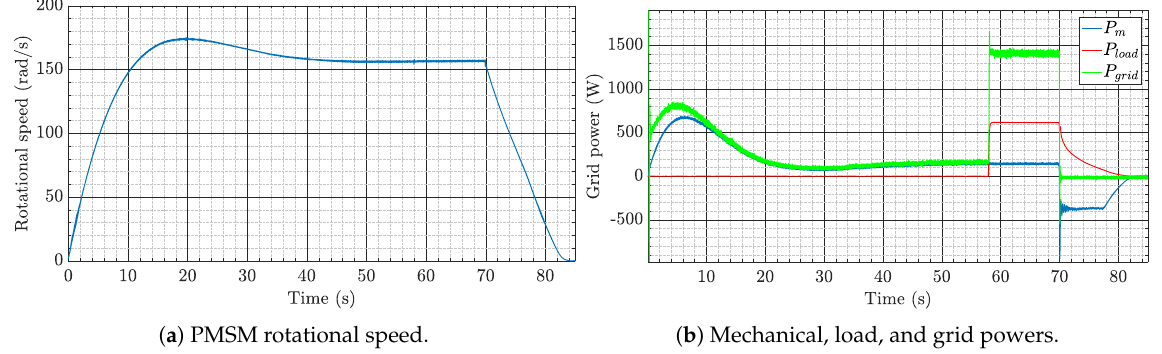
Figure 18. Experimental results for grid